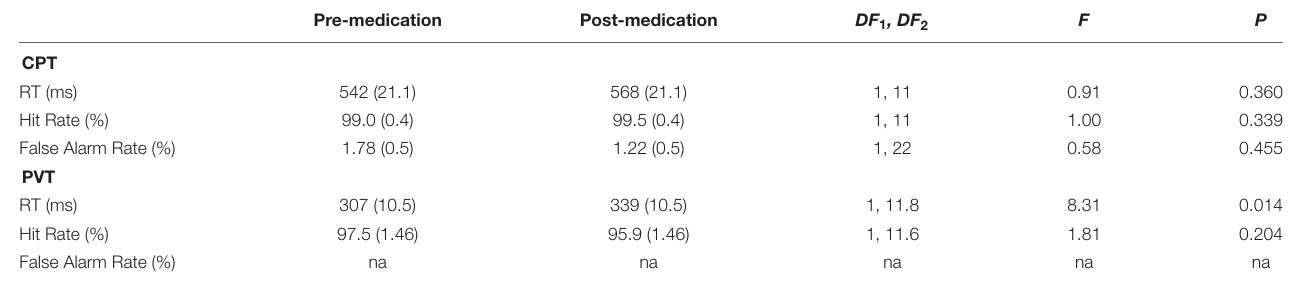
*Data represent marginal means and standard error in parentheses. CPT, Continuous Performance Task; PVT, Psychomotor Vigilance Task; RT, Reaction Time in ms; Hit Rate, correct reaction to target stimuli in percentage; False Alarm Rate, reaction to non-targets in percentage; DF 1 , numerator degrees of freedom; DF 2 , denominator degrees of freedom; F, F-statistics; P, p-value. Data were obtained before and after 30 min of a subcutaneous scopolamine injection of 0.175 mg.